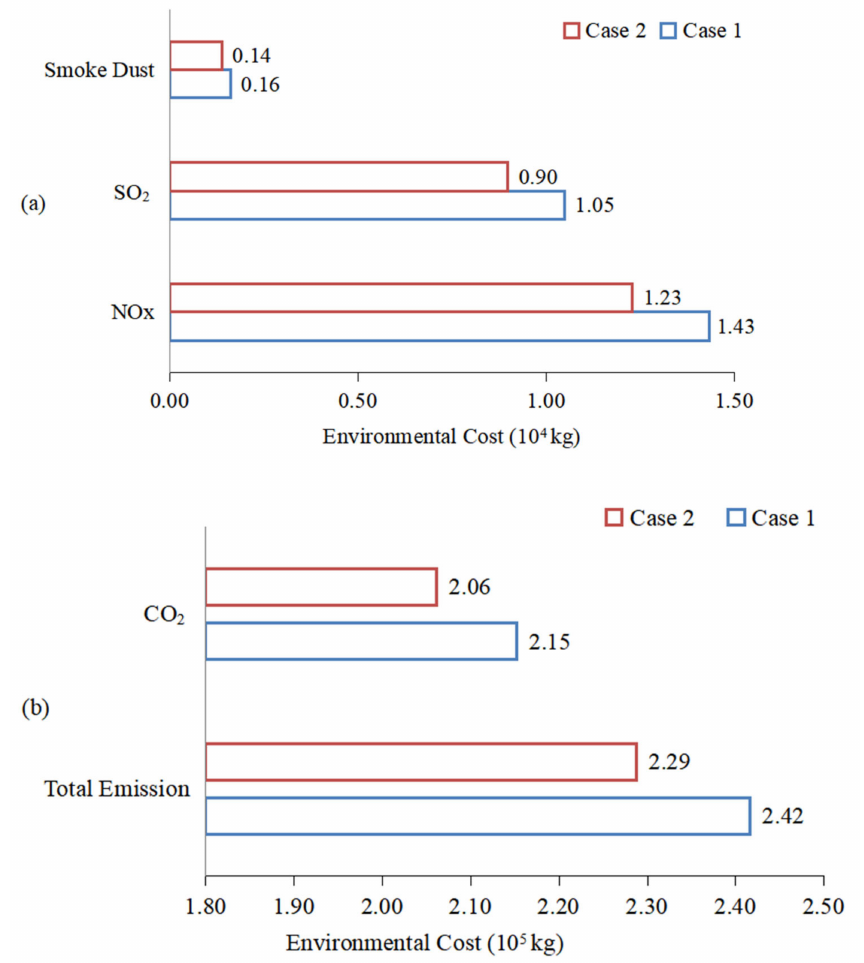
Figure 18. The emissions of SO 2 , NOx, smoke dust, CO 2 , and total environmental costs for each case: ( a ) is the environment costs of smoke dust, SO 2 and NOx; ( b ) is the environment costs of CO 2 and total